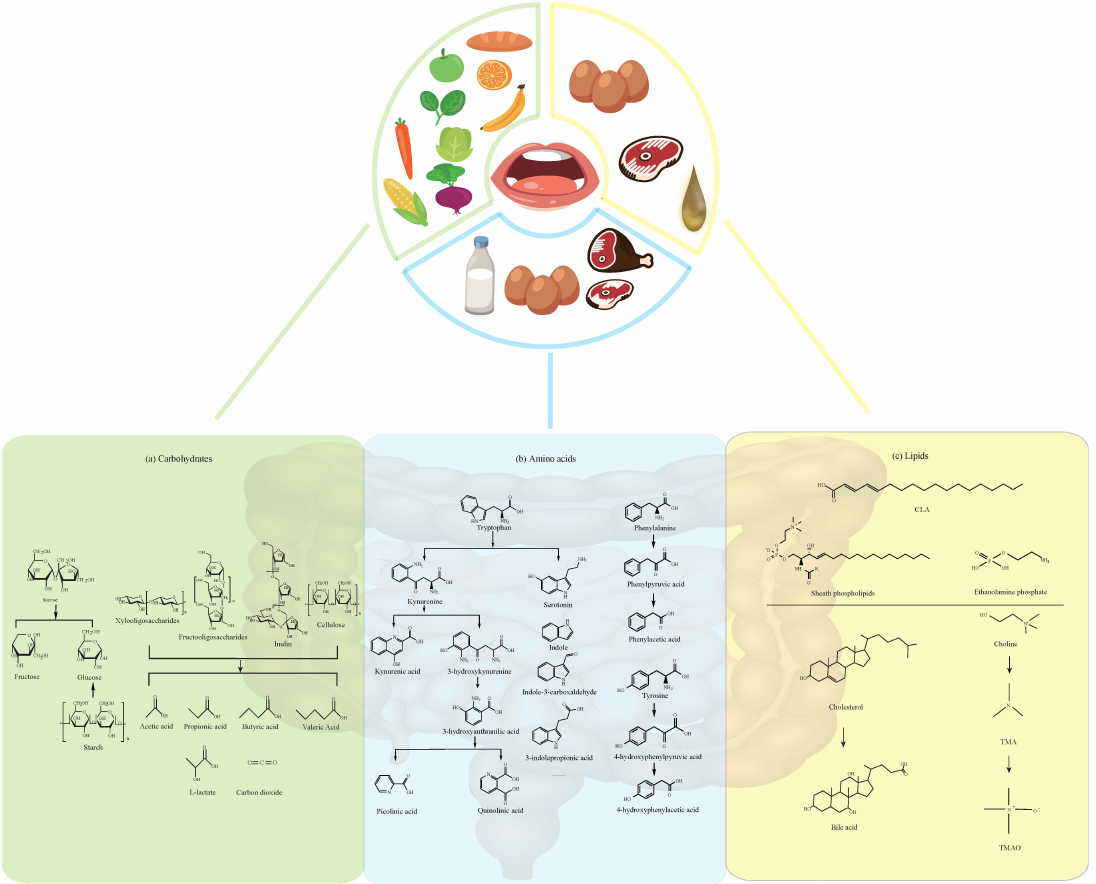
Figure1. Foodsthatweconsumearemetabolizedbytheintestinalmicrobiota.